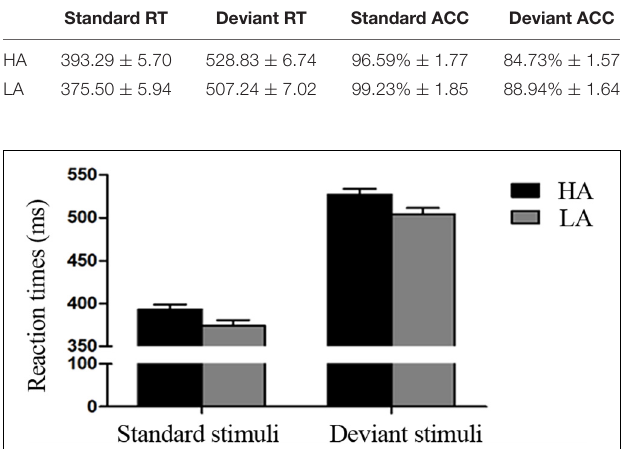
FIGURE 2 | Behavioral results. Mean reaction times (RTs) for low-altitude (LA) and high-altitude (HA) groups under the standard and deviant